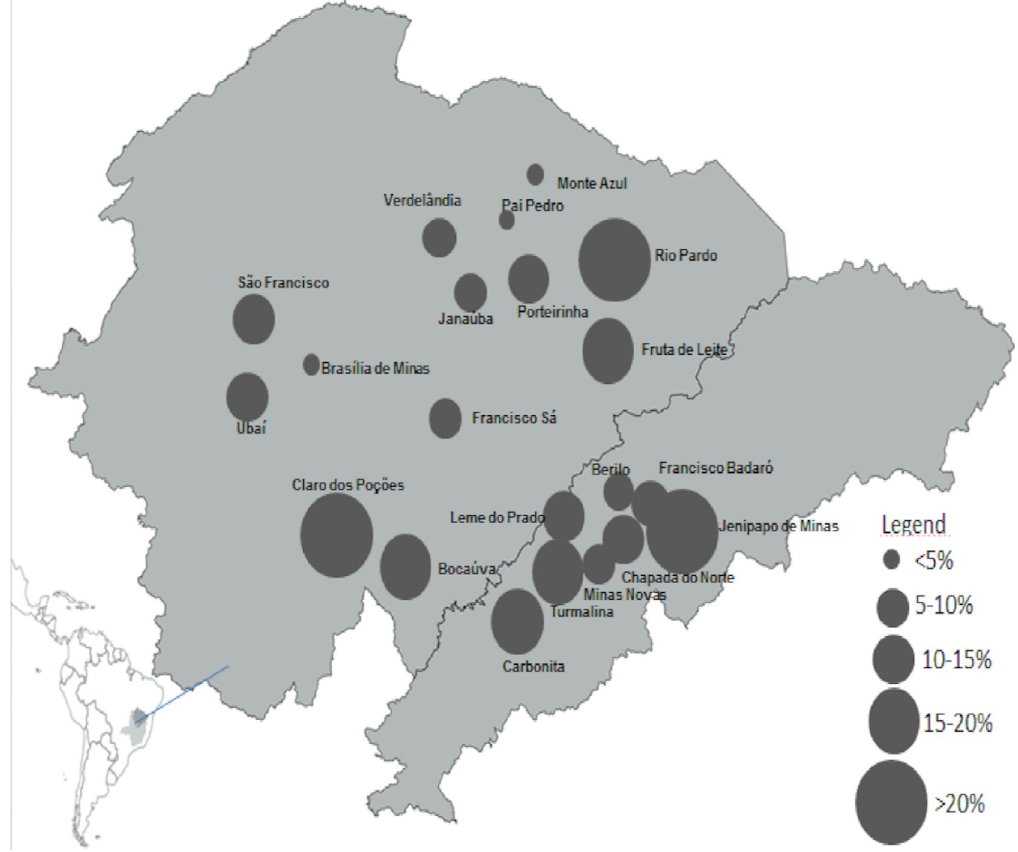
Fig 3. Occurrence of cardiovascular events over two years in Chagas Disease (CD) patients and their distribution by municipality (n = 21). Minas Gerais, Brazil. Created with